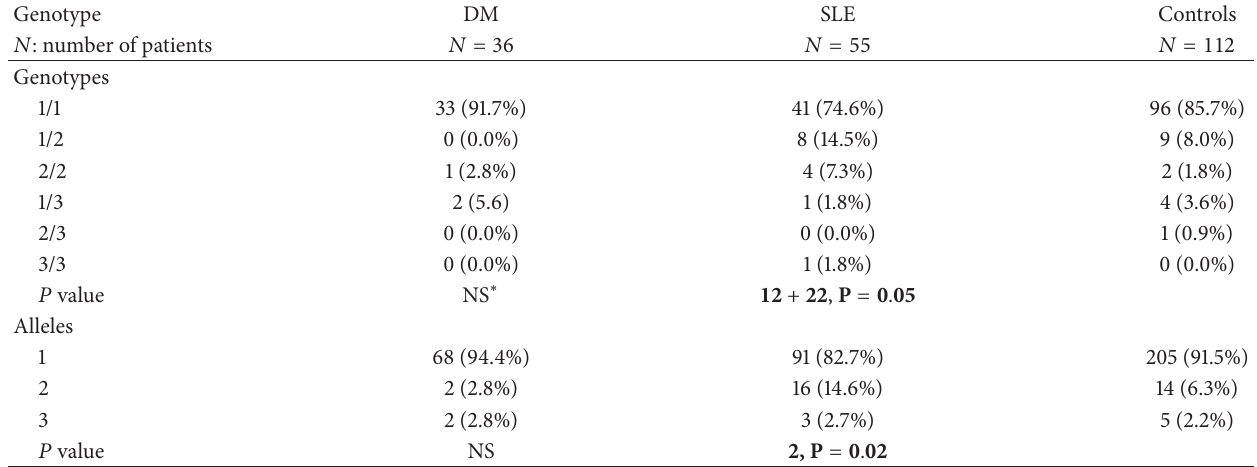
Table 2: Genotype and allele frequencies of the IL-1RN VNTR polymorphism among patients with DM, SLE, and controls.